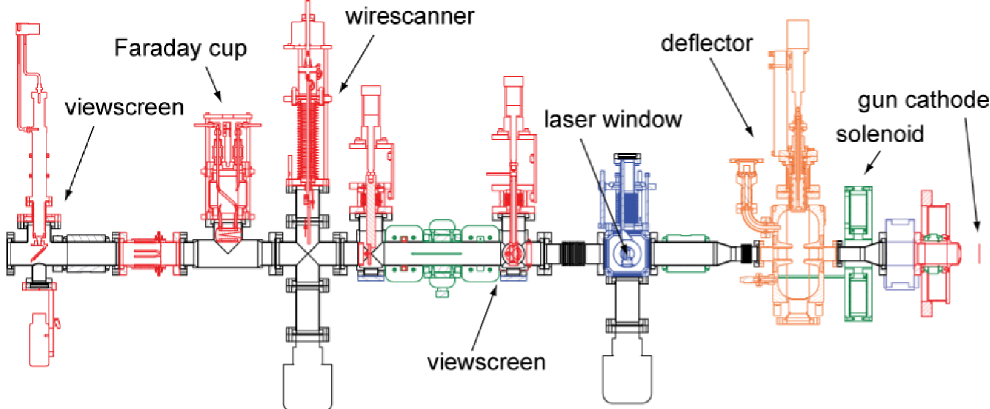
FIG. 1. (Color) Beam line used for temporal profile measurements. Beam direction is to the left.